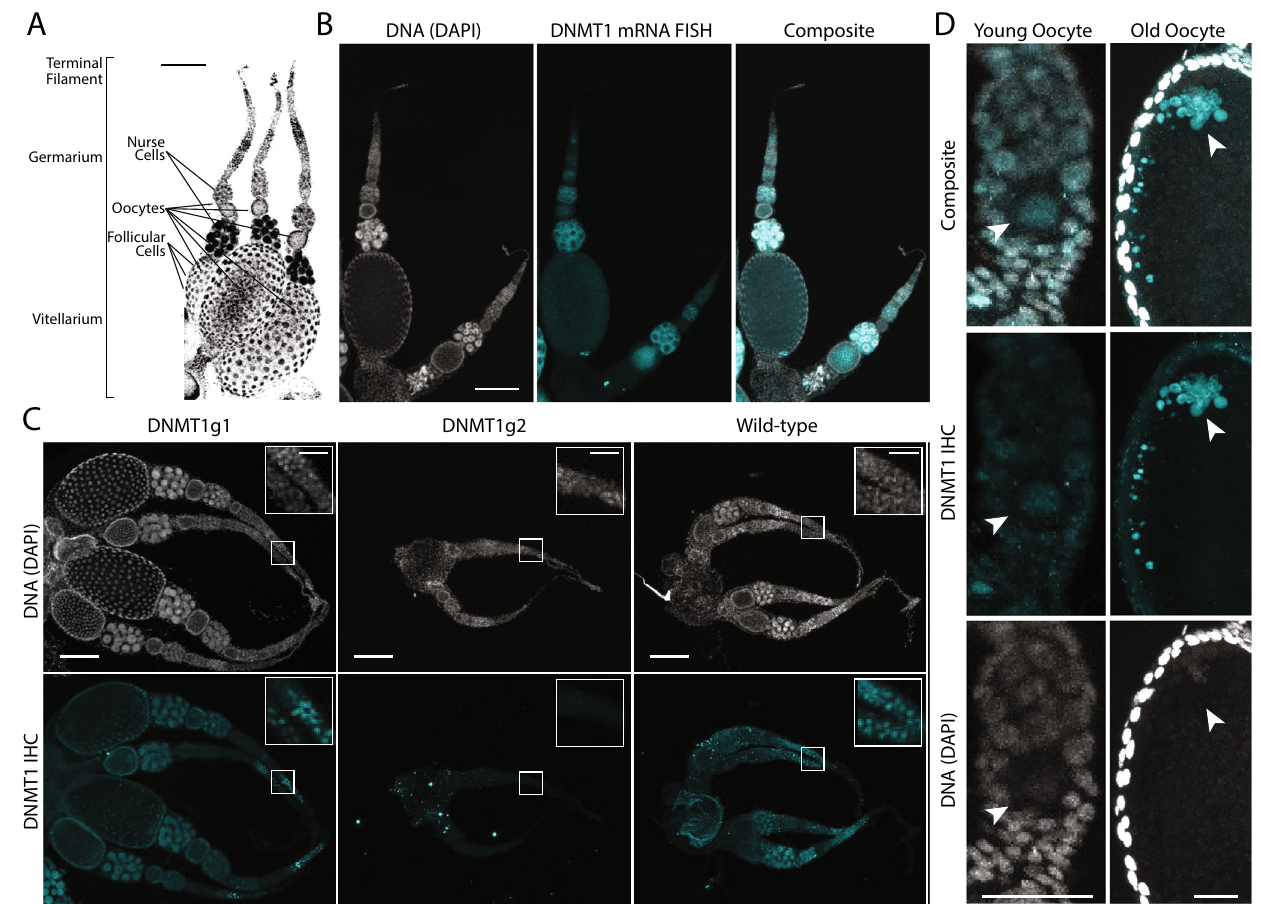
Fig. 3 | DNMT is maternally provisioned into the oocyte. A DAPI stain (black) of DNAshowingtheanatomyofaclonalraiderantovarywiththreeovarioles.Oocytes arisefromstemcellsinthegermariumandtraveltothevitellariumastheydevelop. Oocytes are surrounded by supporting follicular cells and adjacent nurse cells (scale bar = 100 μ m). B mRNA FISH of DNMT1 in clonal raider ant ovaries. DNMT1 staining is observed in nurse cells, germarium cells, and oocytes (scale bar = 100 μ m). C Protein immunohistochemistry (IHC) of DNMT1 in the ovary of DNMT1 mutants(left,center)andacontrolwild-typeant(right).DNMT1stainingisvisiblein the germarium, nurse cells, and follicular cells of wild-type and DNMT1g1 mutant ovaries. No staining is apparent in the DNMT1g2 mutant, corresponding to